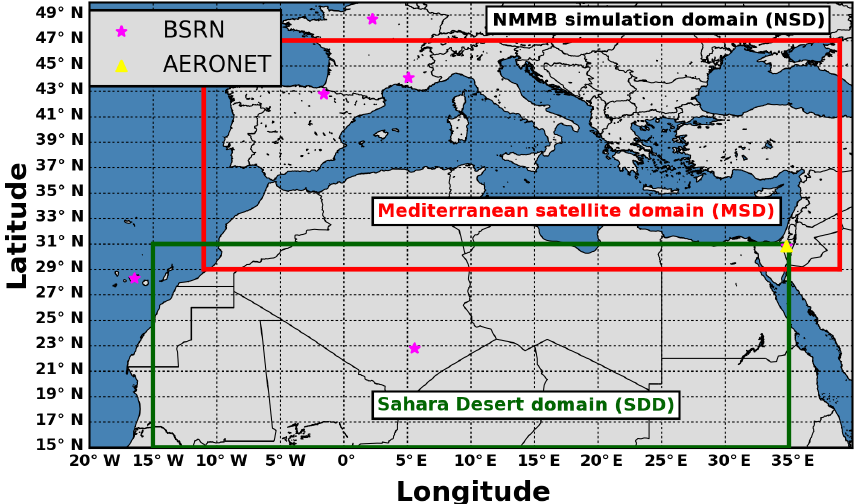
Figure 1. Geographical limits of the (i) NMMB simulation domain (NSD, outer domain), (ii) Mediterranean satellite domain (MSD, red rectangle) and (iii) Sahara desert domain (SDD, green rectangle). The magenta star symbols depict the locations of the BSRN stations and the yellow triangle denotes the location of the AERONET SEDE_BOKER